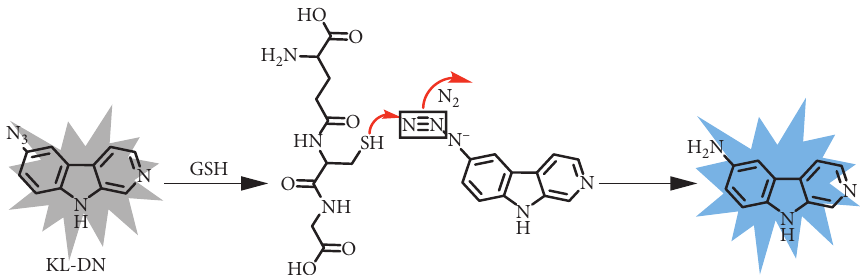
Scheme 1: Chemical structure of KL-DN and the proposed